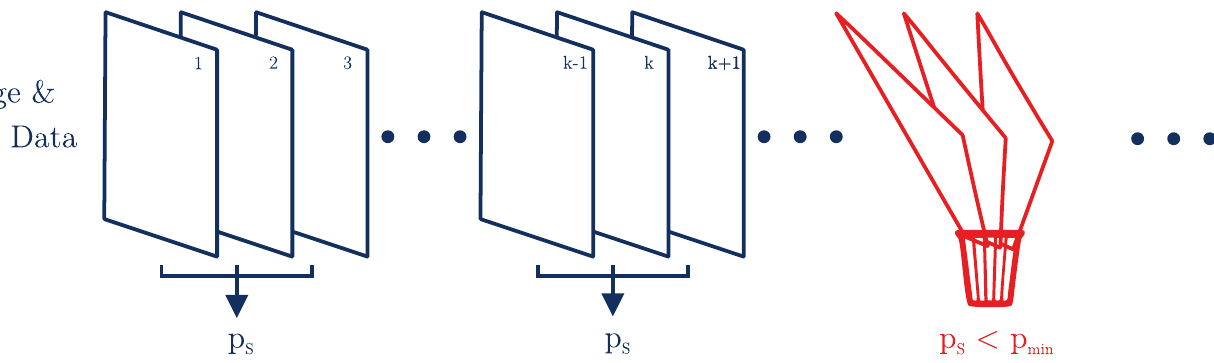
Figure 12. The performance evaluation of image and strain data. Frame pairings which do not fulfill the minimum performance requirement are not considered for the computation of the elastic